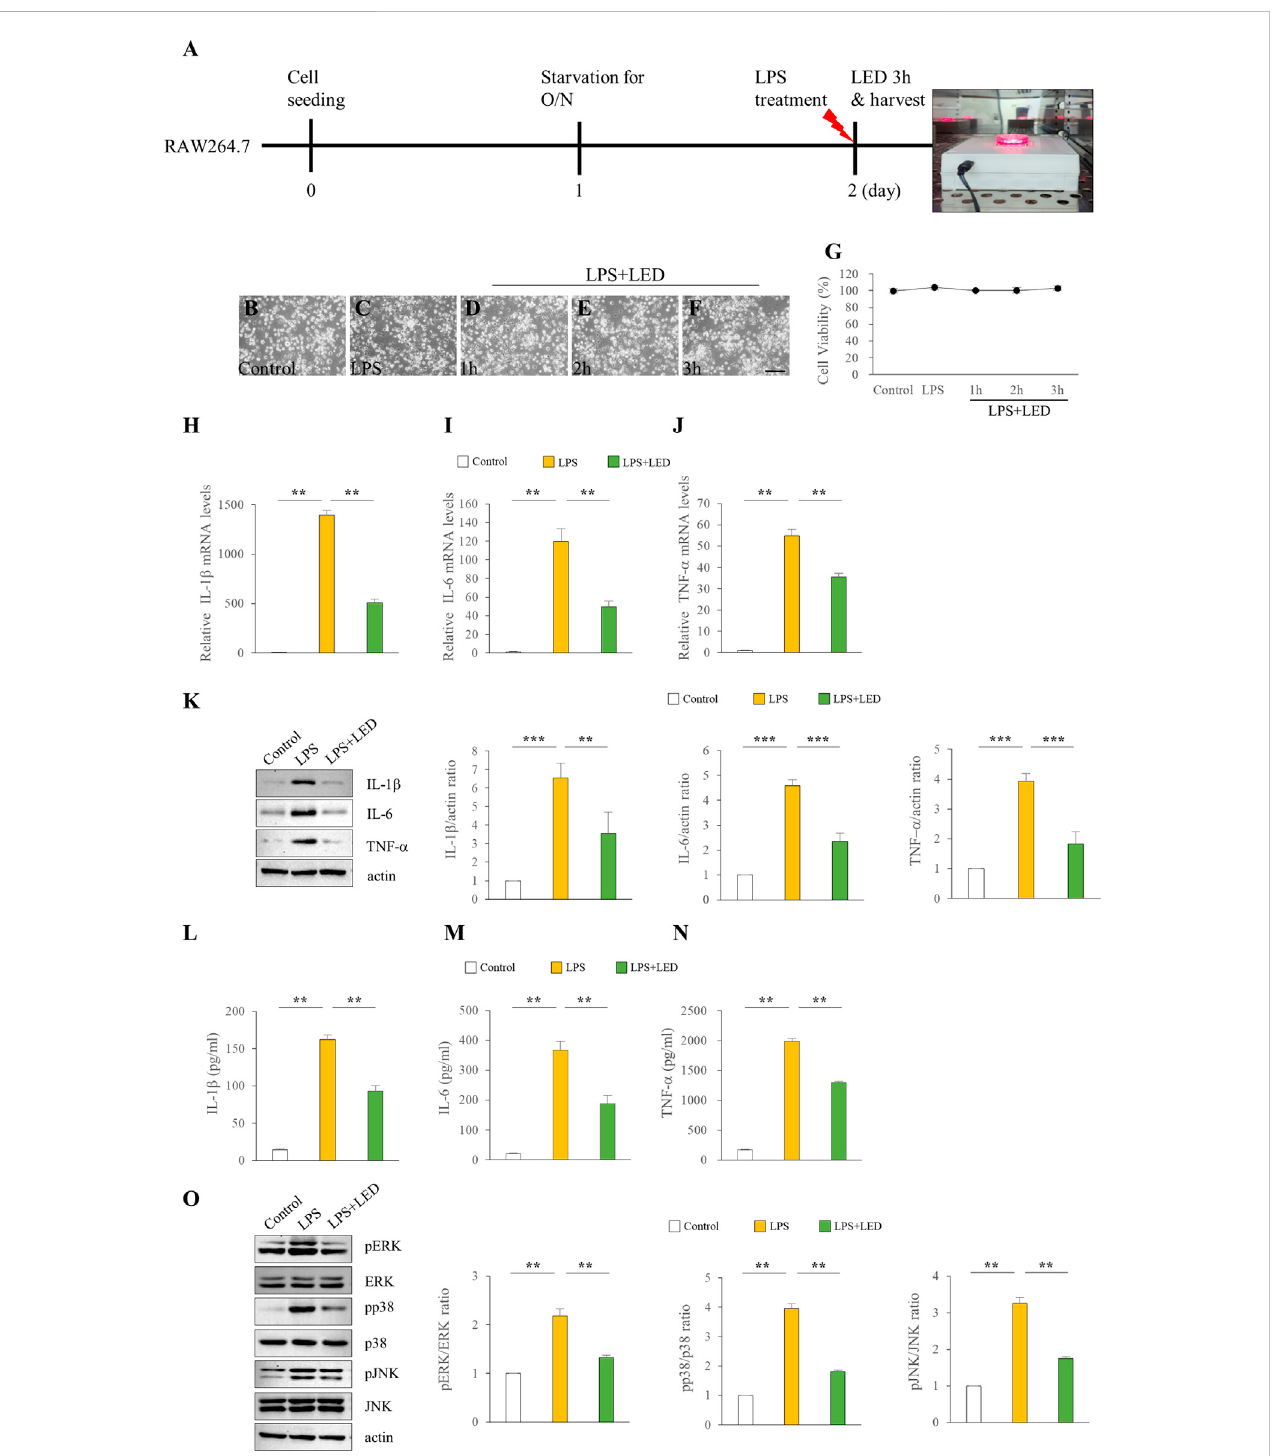
FIGURE 5 Reduction of the expression of pro-in fl ammatory cytokines in RAW 264.7 cells by LED irradiation. Treatment of RAW 264.7 cells with LPS (50 μ g/ml or 10 μ g/ml) for 3 h (A) . Cell morphology (B – F) and viability (G) of RAW 264.7 cells following LED irradiation. The scale bar represents 200 µm (B – F) . qPCR assay ofthemRNAlevelsofIL-1 β (H) ,IL-6 (I) ,andTNF- α (J) inRAW264.7cells(n=6).KruskalWallistest:( p )=0.001.Dataarepresentedastherelativefold.Western blotting of the protein expression levels of IL-1 β , IL-6, and TNF- α (n = 9) (K) . One-Way Anova: * p < 0.05, ** p < 0.01, and *** p < 0.001. ELISA of pro- in fl ammatory cytokines including IL-1 β (L) , IL-6 (M) , and TNF- α (N) in RAW 264.7 cells (n = 3). Kruskal Wallis test: ( p ) = 0.001. Reduction of pro-in fl ammatory cytokines byLEDirradiationthroughtheblockadeofMAPK signaling (n=6) (O) .KruskalWallis test:( p )=0.00039forpERKandpp38and( p )=0.001 forpJNK. Mann-Whitney U test: * p < 0.05, ** p < 0.01, and *** p < 0.001. Data are expressed as the mean ±